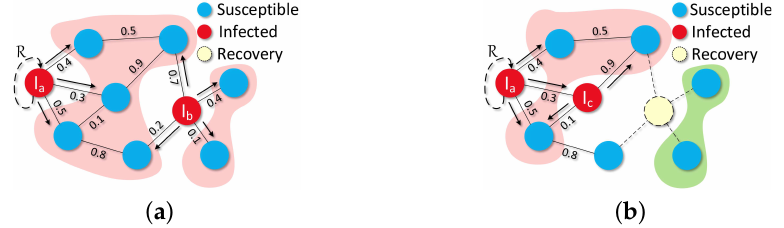
Figure 3. SIR transmission process: At t = 0, I a and I b are the initial infected nodes in G ( V , E ) . Those two nodes are trying to infect their neighbors through weighted connection edges. At the same time, both I a and I b are struggling to become recovered by using their own antibodies, the probability of occurrence of this event is R . At t = 1, a new infectious node I c is coming and trying to infect its neighbors, fortunately, I b overcame the hateful disease and protected its neighbors (which are in the green area) from being infected. ( a ) t = 0; ( b ) t =